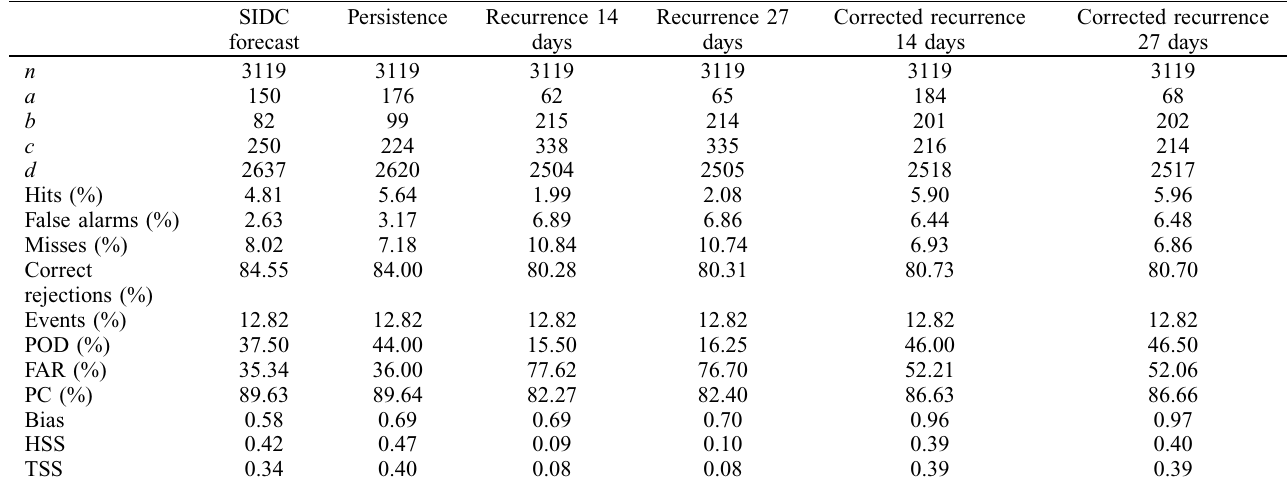
Table 3. Skill scores for the SIDC forecast and numerical models for the forecast of flare events of classes M or